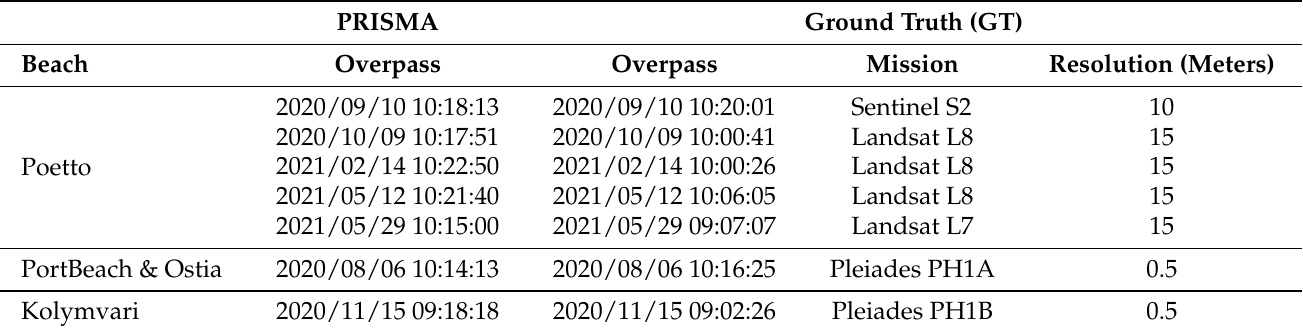
Table 3. Concurrent overpasses of PRISMA with medium and high-resolution satellite images used to digitise the shorelines, the image-based GT.